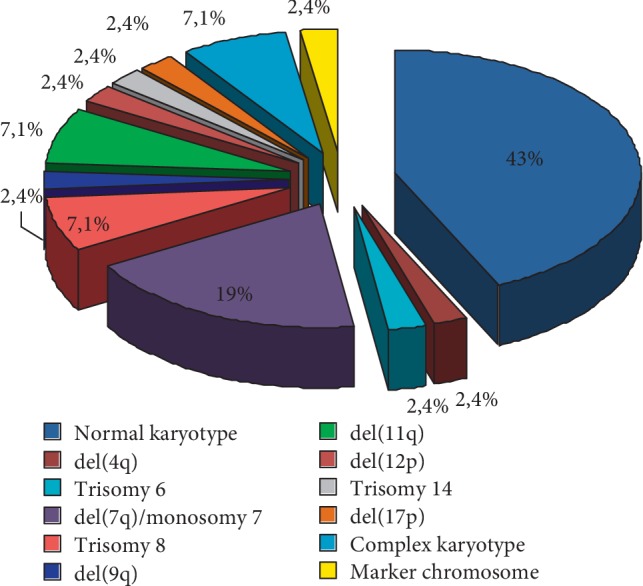
Frequency of chromosomal abnormalities in pediatric patients with primary MDS.